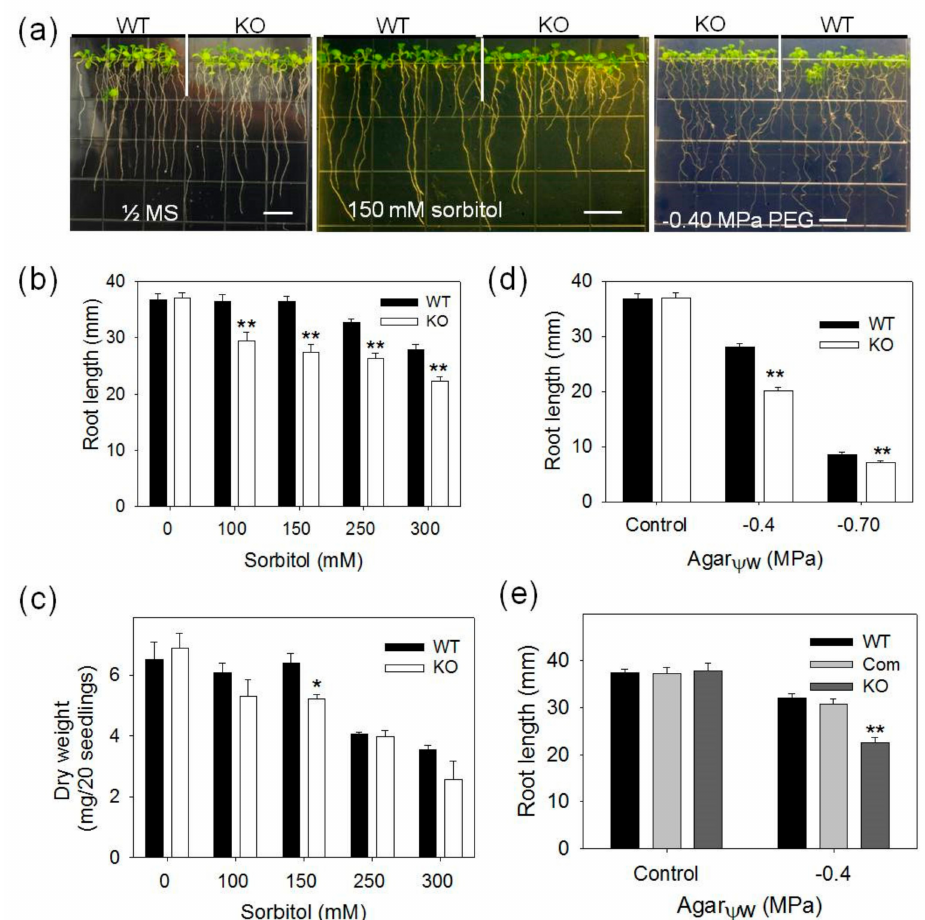
Figure2. Responsesof pPLAIII γ -KO,COMandWT Arabidopsis plantstosorbitolandpolyethyleneglycol (PEG). ( a ) Representative images under di ff erent sorbitol and PEG concentrations; ( b , c ) quantification of seedling growth in response to di ff erent levels of sorbitol. Three-day-old seedlings germinated on 1 MS media after stratification were transferred to plates with 0, 100, 150, 250 and 300-mM 2